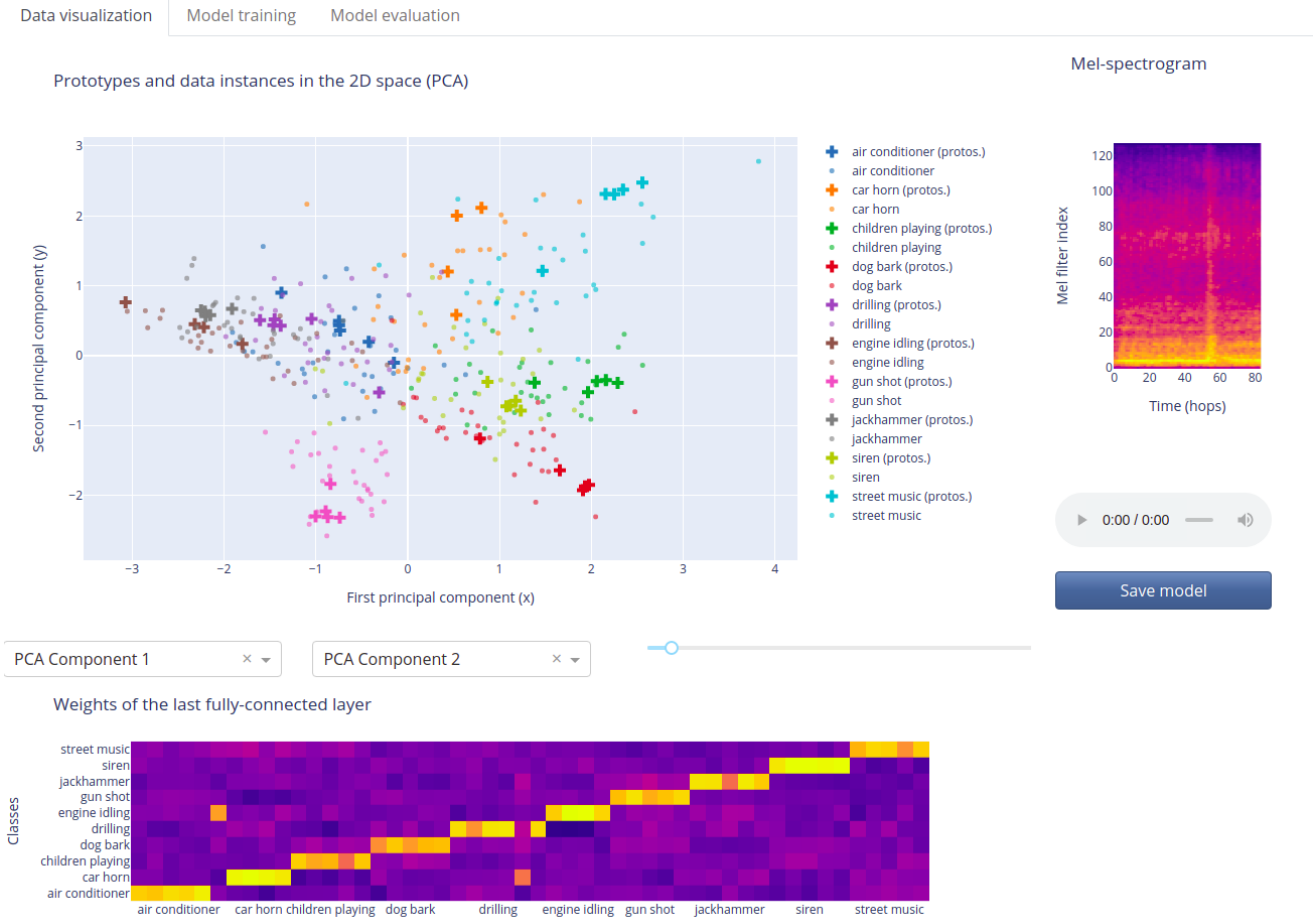
Figure 10. Screenshot of the web application designed for the manual editing of APNet. In this tab the user can navigate through the training set and the prototypes in a two-dimensional (2D) space, listen to the audio files and explore the mel-spectrograms. It is also possible to delete prototypes and convert data instances into prototypes. Other tabs include functions for training and evaluating the edited